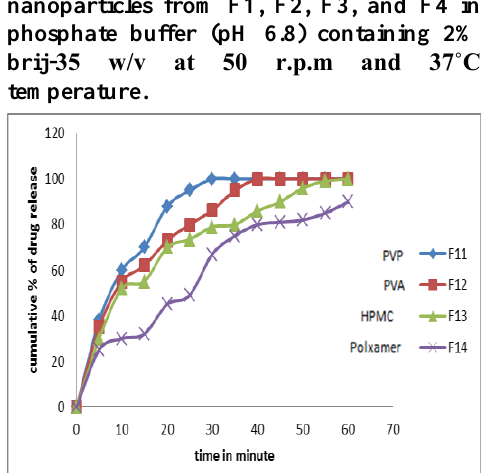
Figure (5): Effect of polymer type on the dissolution profile of ezetimibe nanoparticles from F11, F12, F13, and F14 in phosphate buffer (pH 6.8) containing 2% brij-35 w/v at and 37˚C temperature.